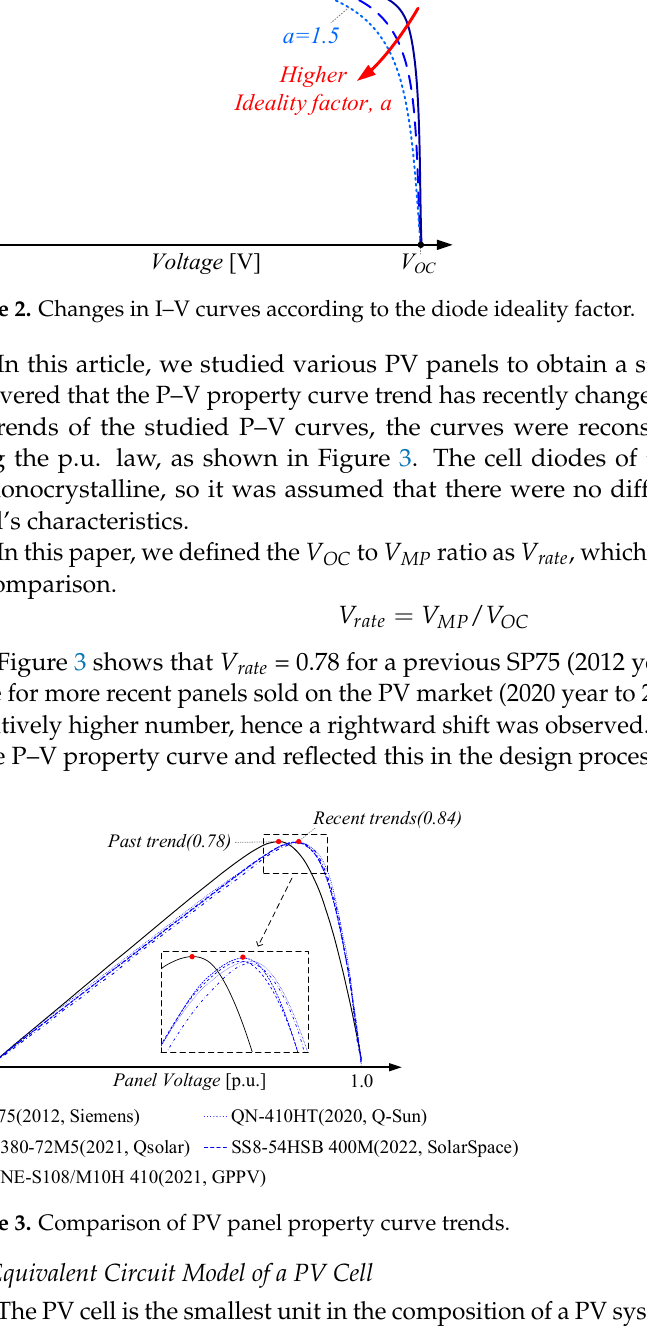
Figure 1. I–V property curve of a general PV panel.